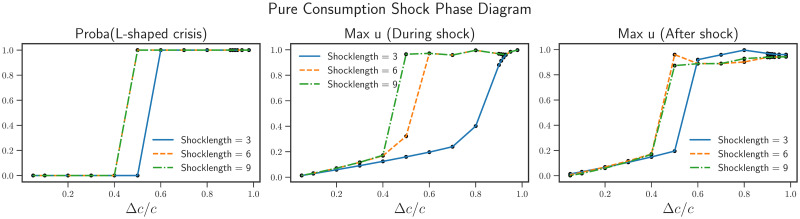
Phase diagram for a pure consumption shock (Δζ/ζ = 0).We observe an abrupt transition to an L-shaped crisis for consumption shocks beyond Δc/c = 0.5 for T = 3 months, and beyond Δc/c = 0.4 for T = 6 or 9 months. Below these shock amplitudes, there is no prolonged crises but short-lived crises are observed. This can be seen by observing the maximum unemployment rate during the shocks: for Δc/c = 0.4, we reach about 15% unemployment. Each of the plots has been obtained by running 500 independent simulations for each value of Δc/c presented here.